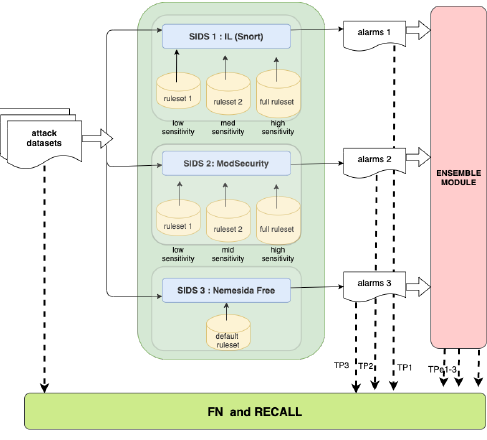
Figure 2. Experiment 1 scheme.